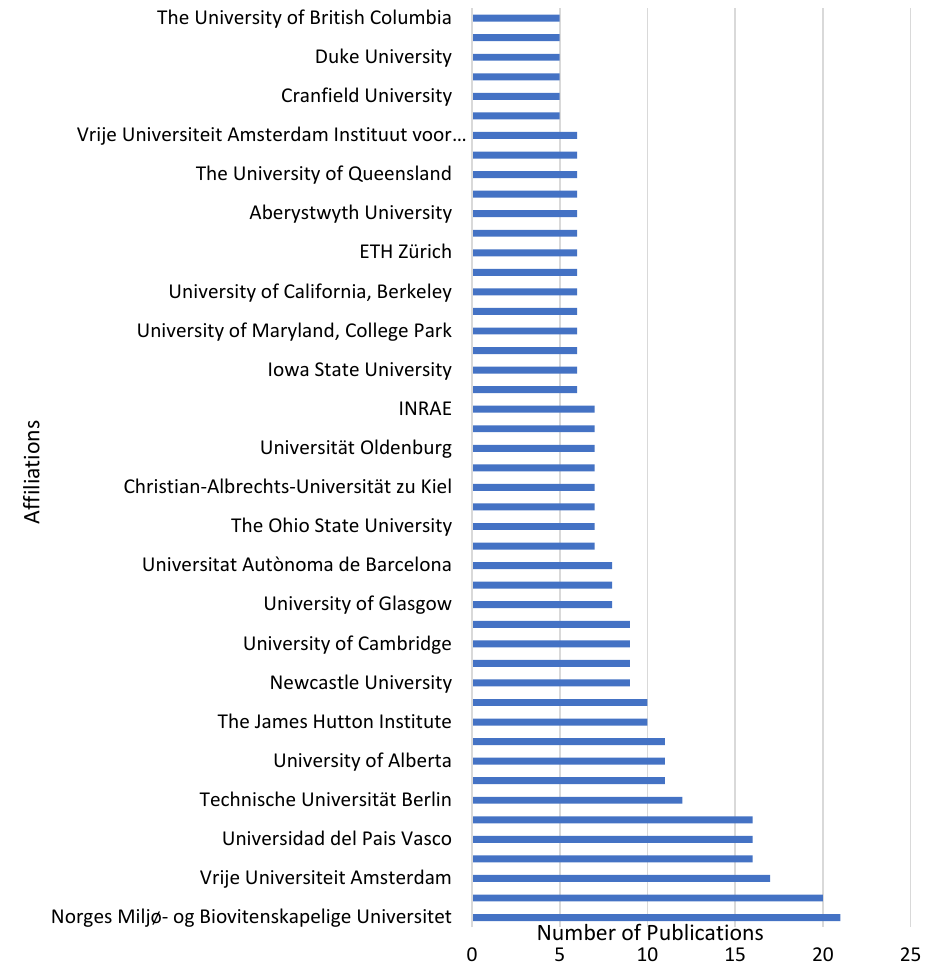
Figure 13. The top affiliations for the research on environmental valuation (data retrieved from Scopus database on 22nd October 2022).